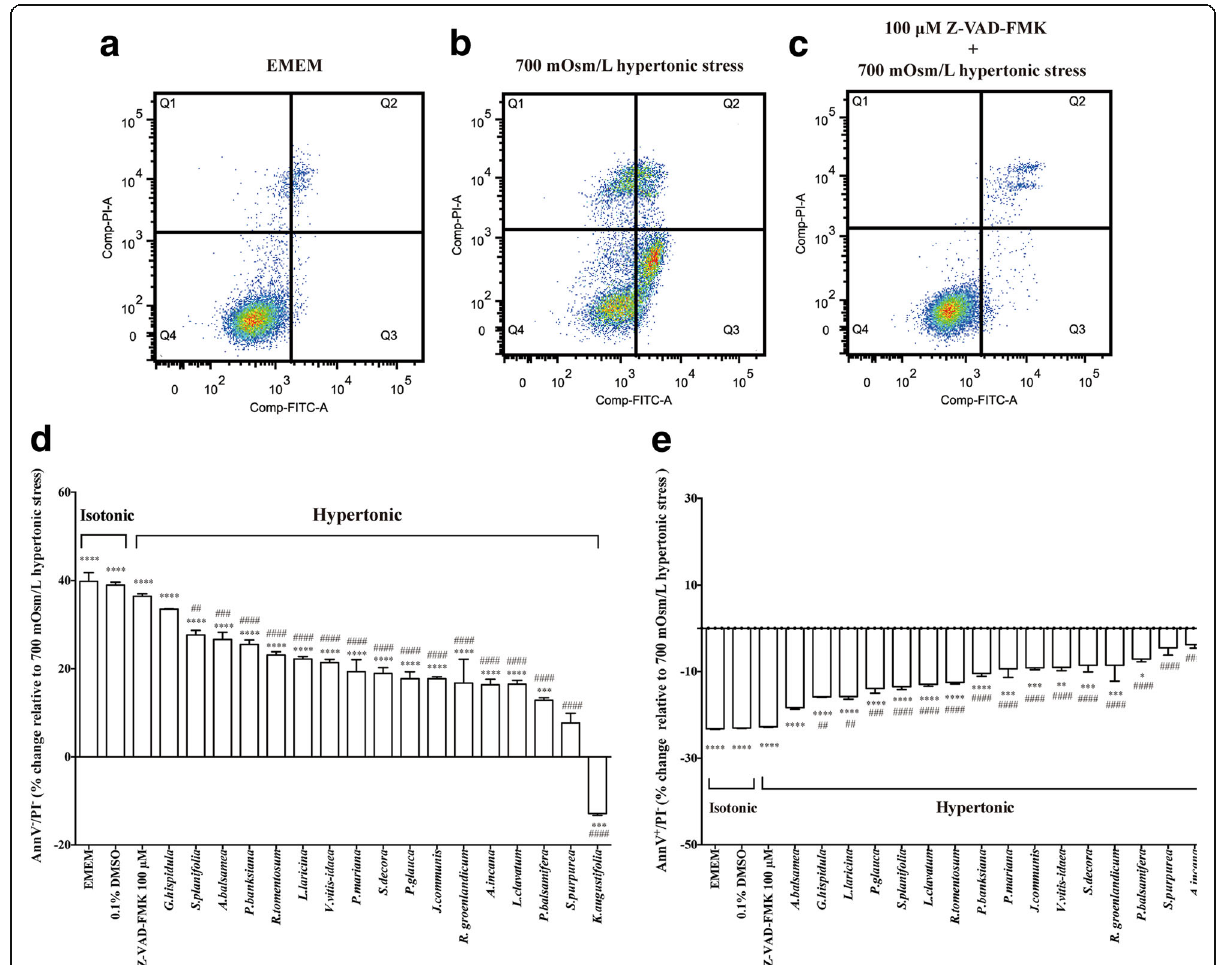
Fig. 1 Renal protective potential of 17 antidiabetic medicinal plant extracts. AnnV/PI labeling was performed 18 h after plant extract treatment to assess viability and early stage apoptosis. a - c Representative pictures of flow cytometry. PI + Quadrants Q1 and Q2 respectively represent necrosis and late stage apoptosis/secondary necrosis; AnnV − /PI − Quadrant Q4 represents viable cells; AnnV + /PI − Quadrant Q3 represents early stage apoptosis; ( d ) Histogram of change in AnnV − /PI − signal (viable cells). Data are presented relative to 700 mOsm/L hypertonic stress to show